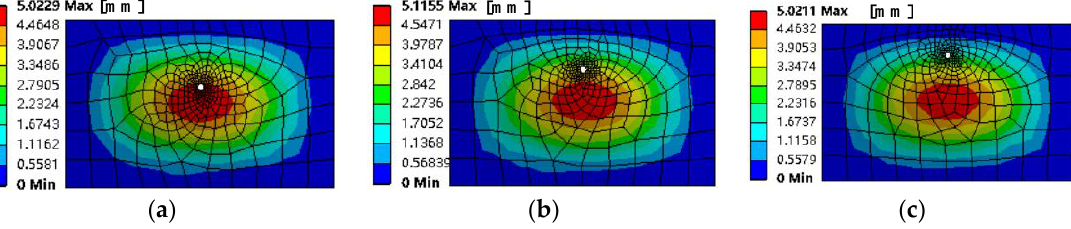
Figure 11. Response diagram of plate with variable hole position. ( a ) Located at 50 mm. ( b ) Located at 100 mm. ( c ) Located at 150 mm.